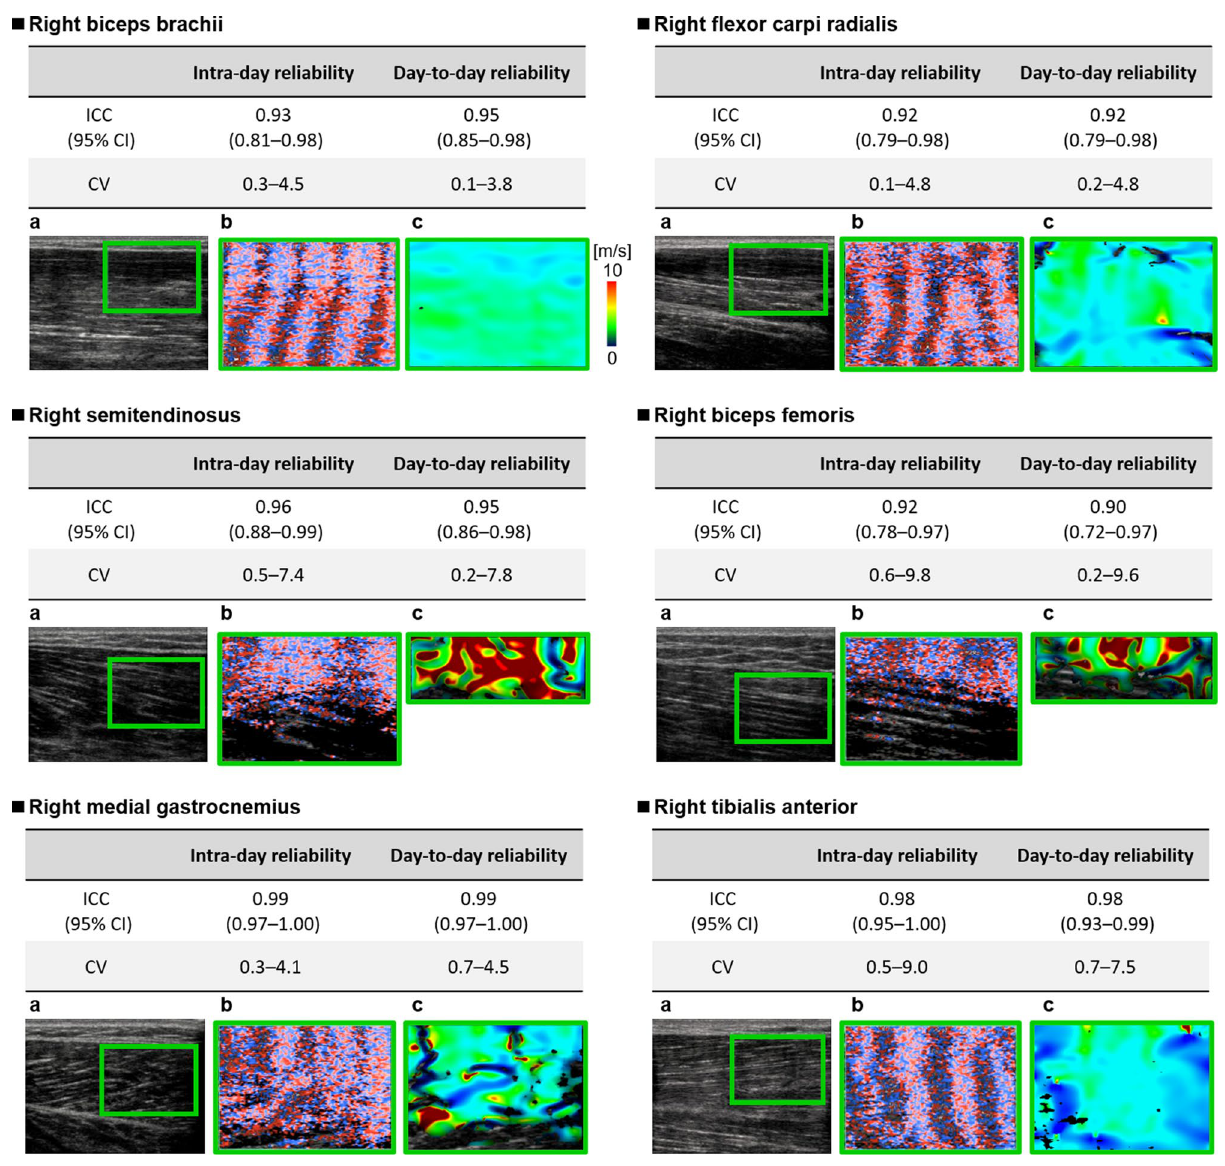
Figure 3. Intra-day and day-to-day reliabilities of shear wave velocity estimation of skeletal muscle stiffness. (a) B-mode image, (b) color flow image, (c) shear wave velocity map. The right biceps brachii, flexor carpi radialis, semitendinosus, biceps femoris, medial gastrocnemius, and tibialis anterior were measured twice per day for 2 days with a between-measurement interval of 1 day (three measurements per trial). For the semitendinosus and biceps femoris, statistical analysis focused on the upper half of the selected area. Results of skeletal muscle shear wave velocity (mean ± standard deviation) are shown in Supplementary Fig. S1